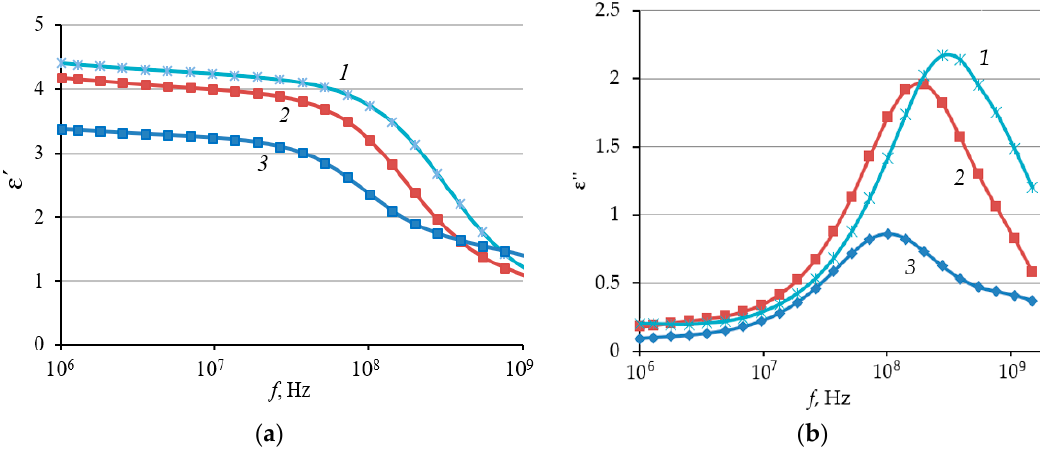
Figure 3. The dielectric spectra ε′ ( a ) and ε″ ( b ), taken at room temperature, for a PBO based polymer film ( 3 ) and photoresist films ( 1 , 2 ) obtained by introducing a photosensitive component into the PBO matrix. The 1st and the 2nd photoresists differ in the methods of purification of one of the monomers when producing POA.